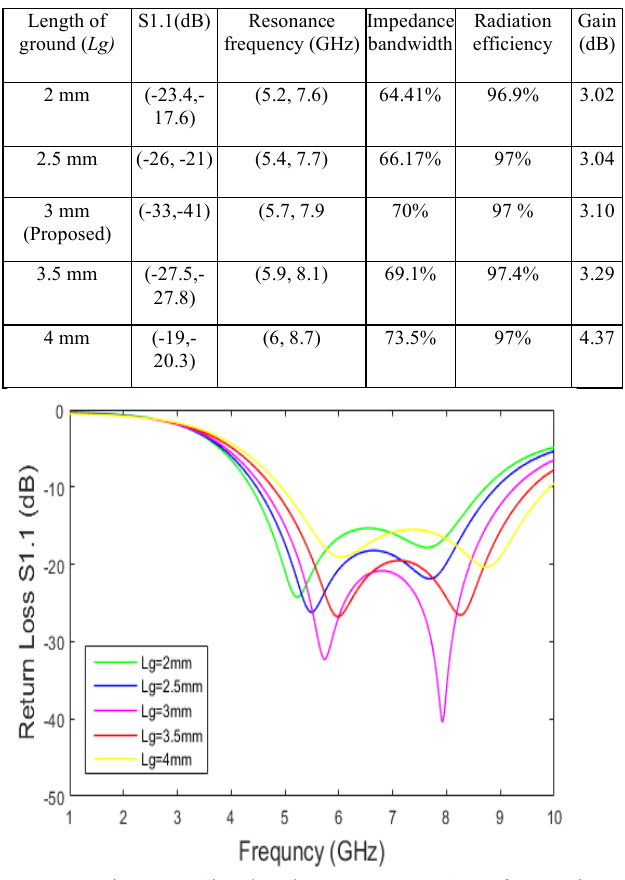
Figure 6 Simulated Return Loss S1.1 for Various Values of length of ground L g